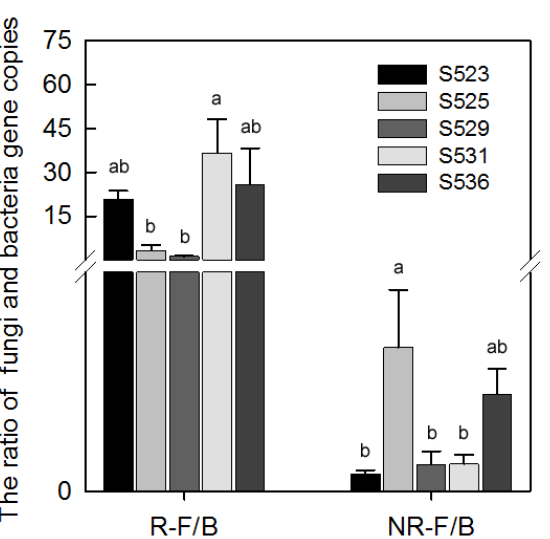
Figure 3. The ratio of bacteria and fungi gene copies (B/F) of rhizosphere (R) and non-rhizosphere (NR) soil in different sub-dams. The different letters (a, b and c) indicate that the means are significantly different among restored sub-dams ( p < 0.05) with the Duncan test.